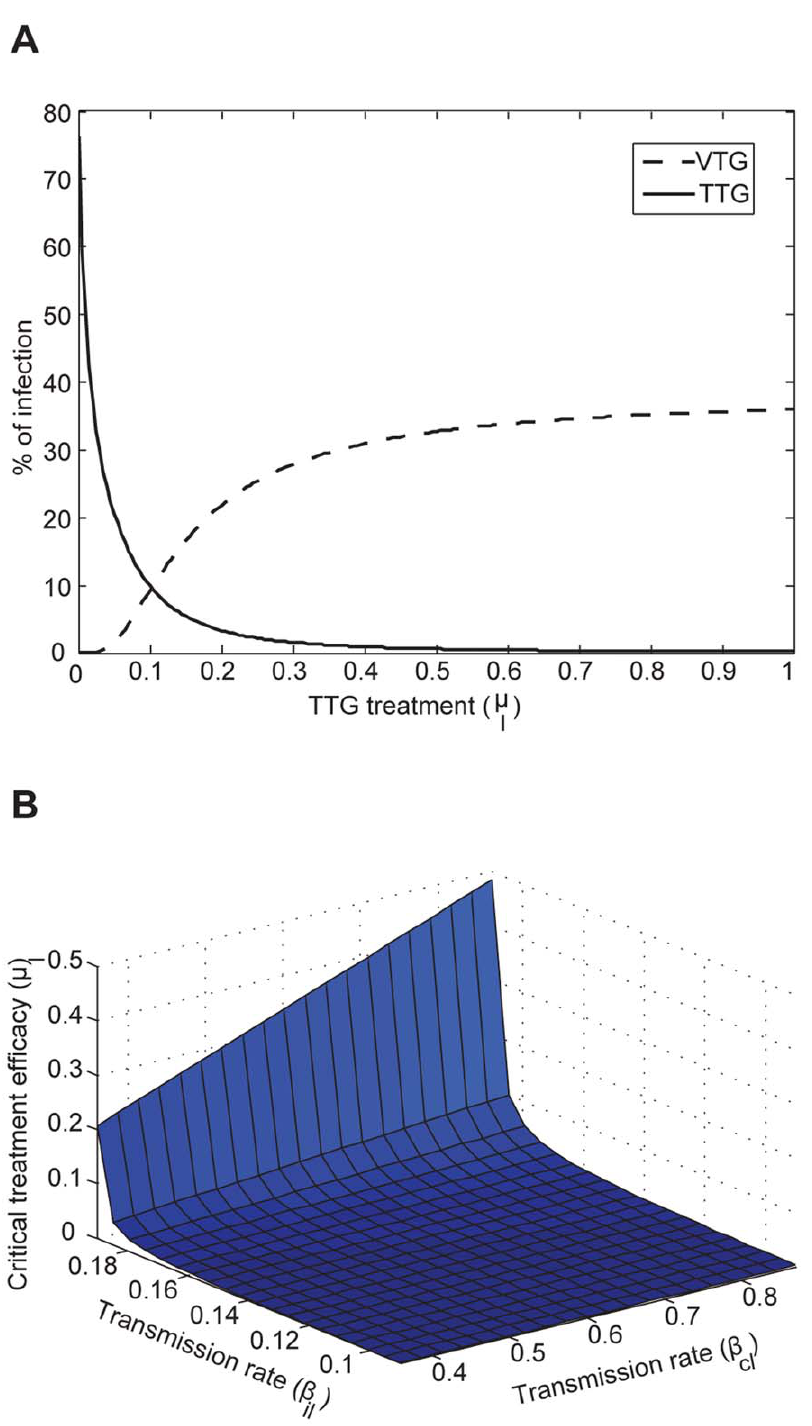
Figure 2. Treatment and vaccine cross-immunity targeted at TTG-MRSA. (A) Effect of different treatment ( m l ) values on TTG, when the competing pathogen, VTG-MRSA, is left untreated. VTG ( I h ) infection increases as TTG infection ( I l ) is eliminated with increased efficacy of treatment. In this analysis baseline and moderate ( b ih= 0.55, b ch =0.13) transmission rates for TTG and VTG are used, respectively. (B) Effects of treatment ( m l ) and cross-immunity ( h l = 77.2%) at different TTG transmission rates ( b il and b cl ). Minimum treatment is required to stop TTG outbreak when a critical cross- immunity value is used